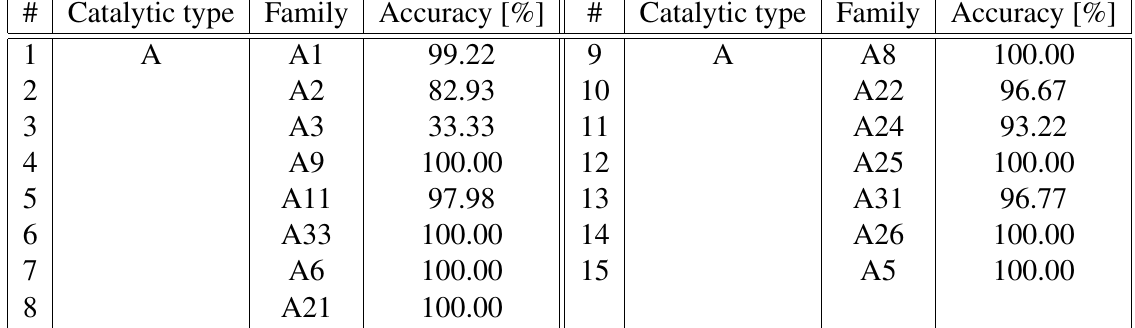
Table 7: Accuracy values for the SVM system for families from catalytic type